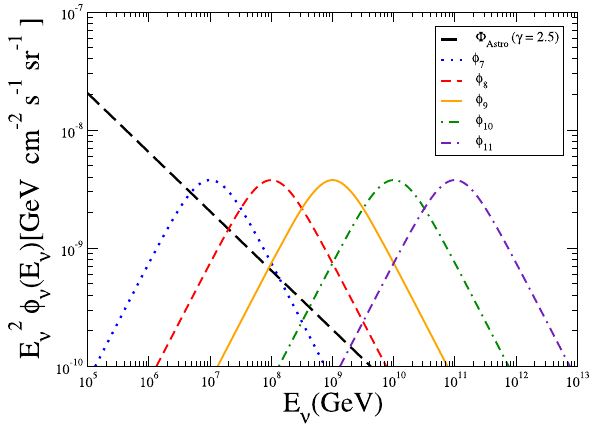
Fig. 3 Comparison between the standard astrophysical flux (cid:6) ( E ν ), given by Eq. (5) with γ = 2 . 5 and (cid:6) astro and the Super-Glashow astrophysical neutrino fluxes, φ j ( E ν ) , which are given by Eq. (7). For the Super-Glashow astrophysical neutrino fluxes, one has imposed an equal peak